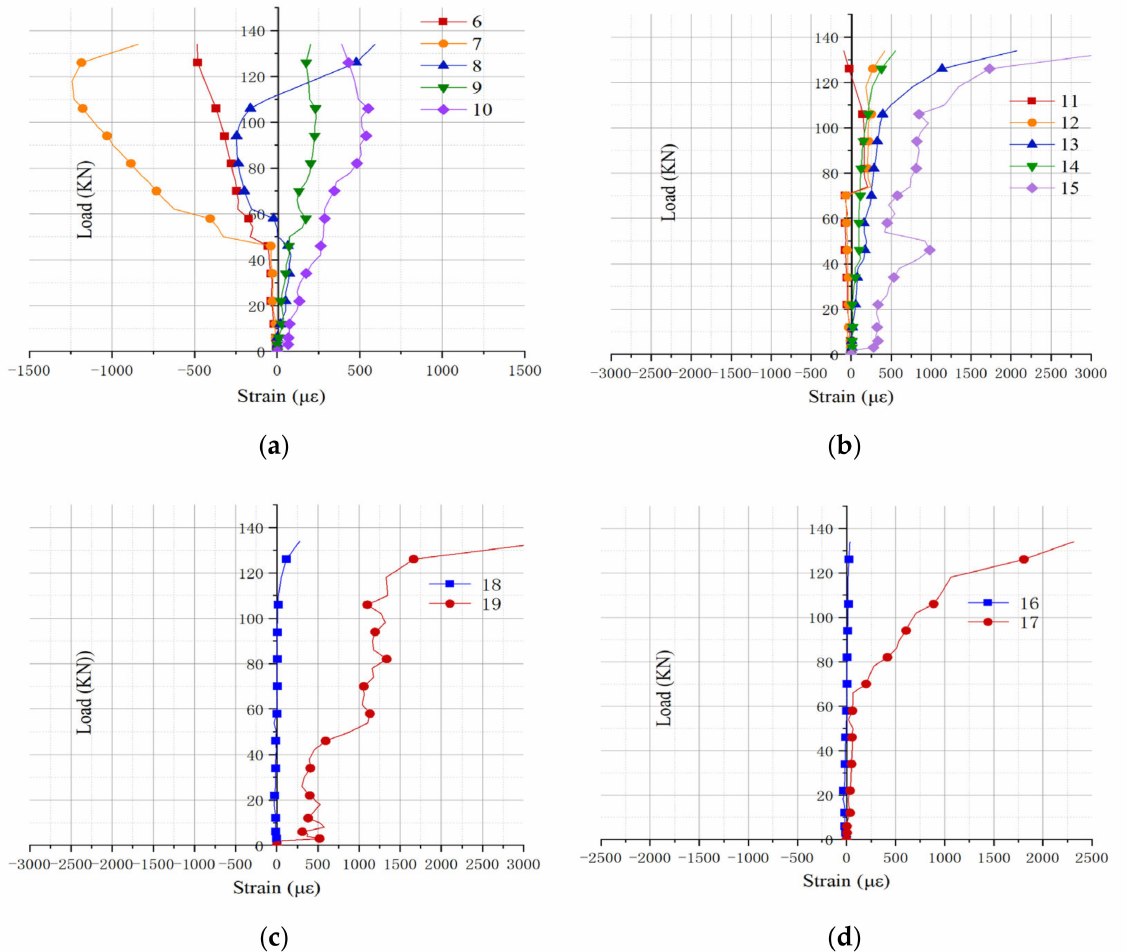
Figure 8. Load-strain curve of different measuring points of L1: ( a ) 6–10 strain gauge; ( b ) 11–15 strain gauge; ( c ) 18–19 strain gauge; ( d ) 16–17 strain